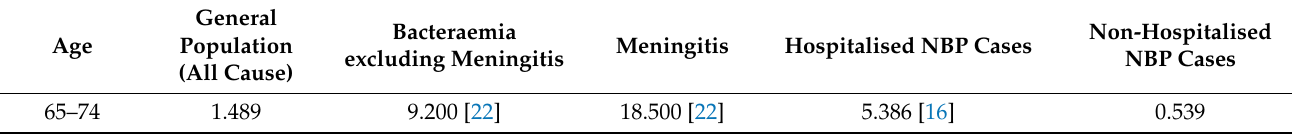
Table 3. Mortality (% values).